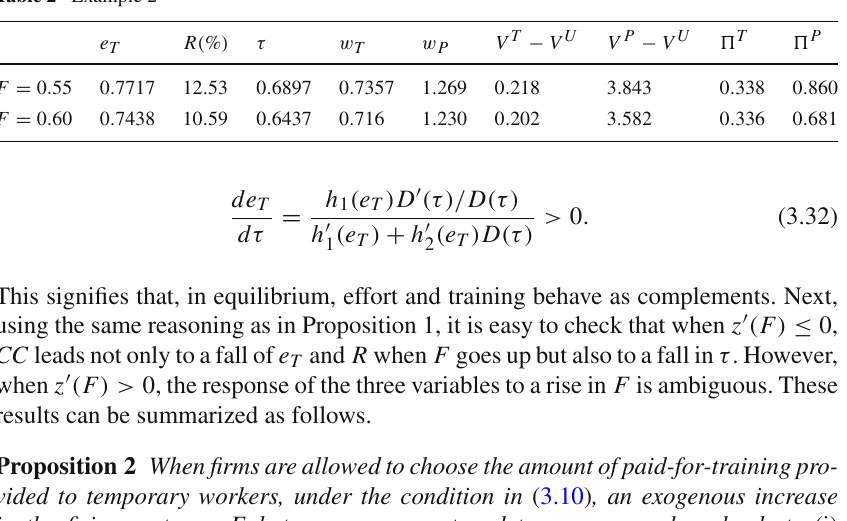
Table 2 Example